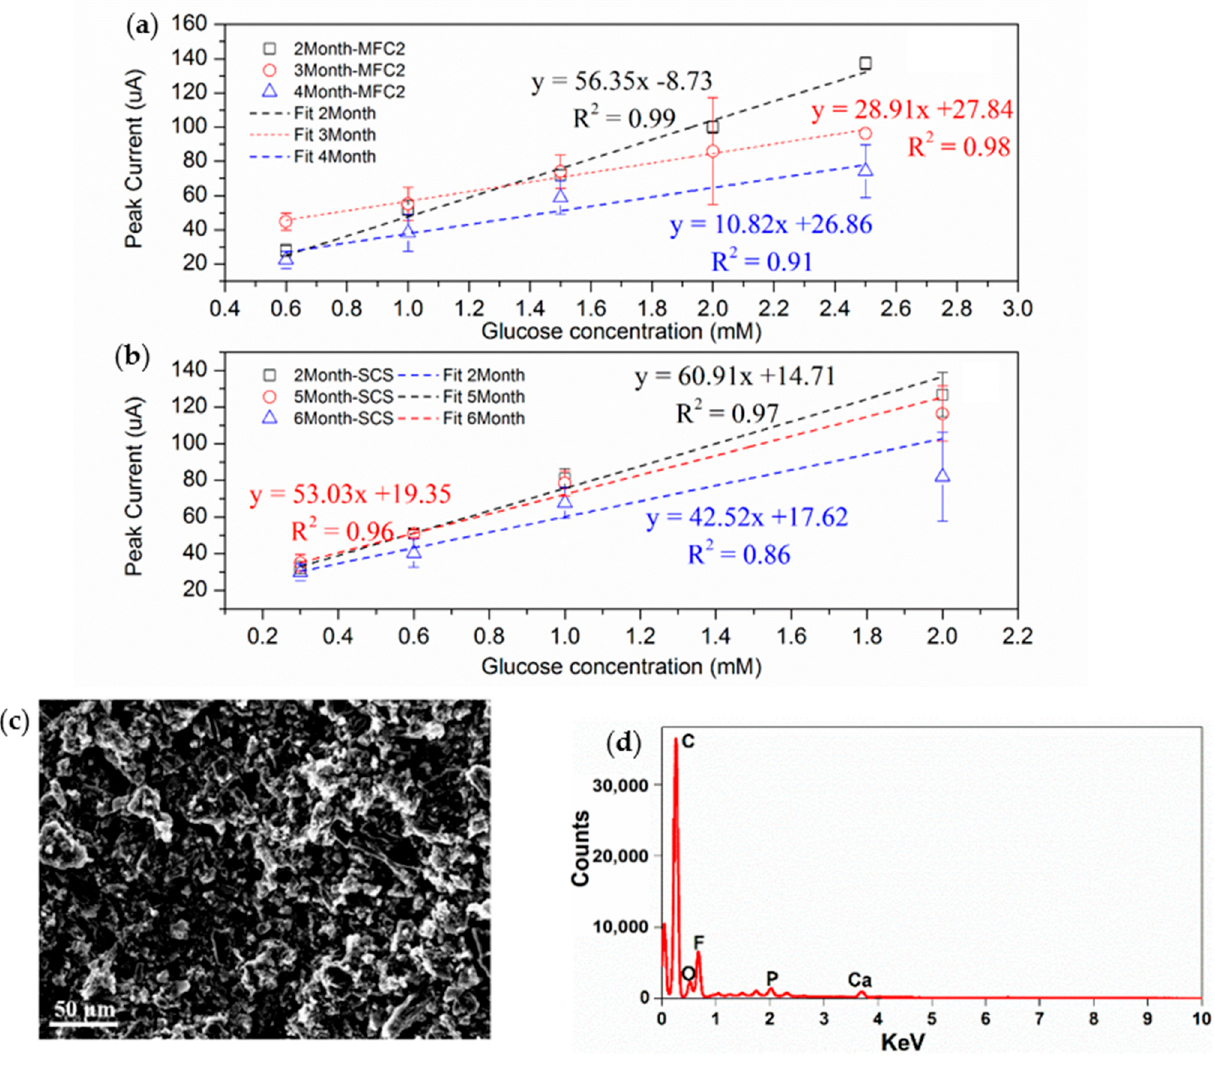
Figure 4. ( a ) Long-term linear correlation between glucose concentration and the peak current of FS2. ( b ) Long-term linear correlation between glucose concentration and the peak current of the CS. ( c ) SEM images of the used CS cathode. ( d ) Full EDX spectra of the used CS